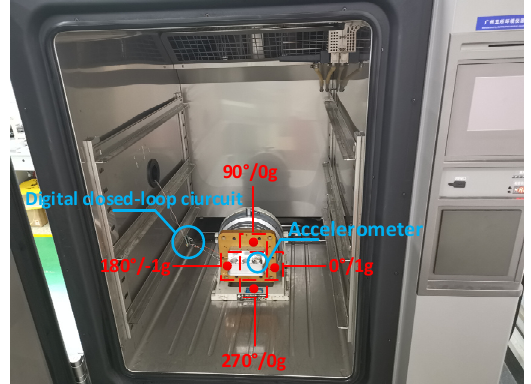
Figure 4. QFA assembled on an index head in temperature ‐ controlled oven, and the index head can be controlled by oven to rotate. The inputs to QFA at 0°, 90°, 180°, 270° are 1 g, 0 g, − 1 g, 0 g. Based on Equation (13), scale factors at different temperatures can be calculated.